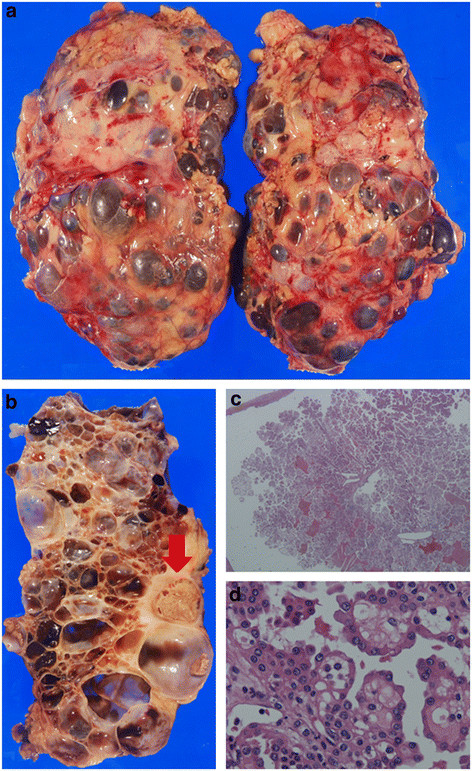
Kidney specimens and tumor histopathology. Kidney specimens from a patient who underwent simultaneous bilateral nephrectomy and histopathologic findings of the left kidney tumor. (A) Right kidney measured 26 × 16 × 13cm and left kidney measured 28 × 17 × 13cm. (B) Cross-section of the left kidney shows a slightly yellow solid tumor (arrow). (C) Hematoxylin-eosin stain, original magnification × 100 and (D) hematoxylin-eosin stain, original magnification × 400 show papillary renal cell carcinoma with large columnar cells with eosinophilic cytoplasm and edematous or fibrous thick stalks.